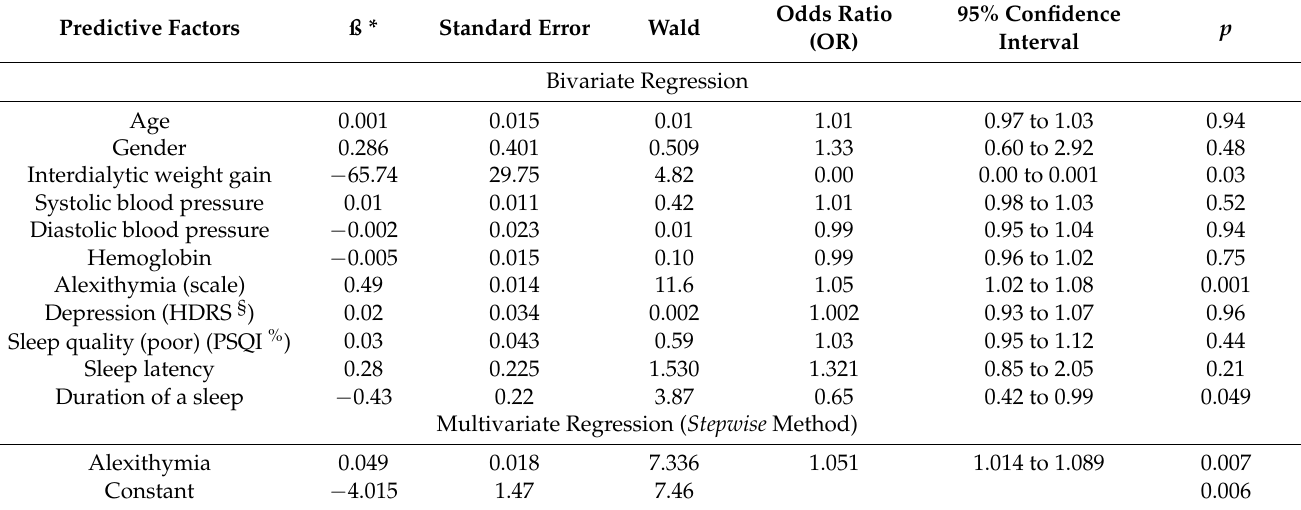
Table 10. Prediction of the probability of daytime sleepiness in participants (Epworth Sleepiness Scale) (bivariate and multivariate regression